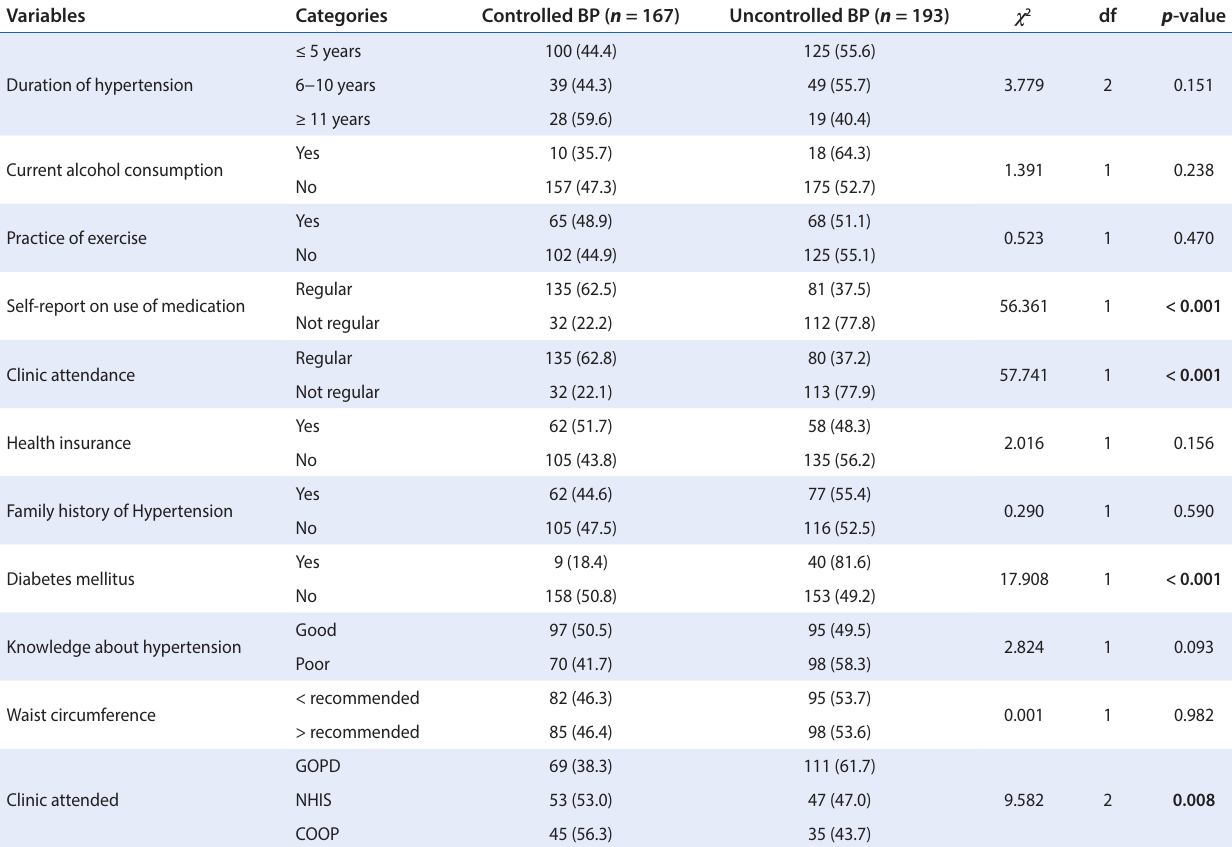
Table 3: Relationship between blood pressure control and clinical factors